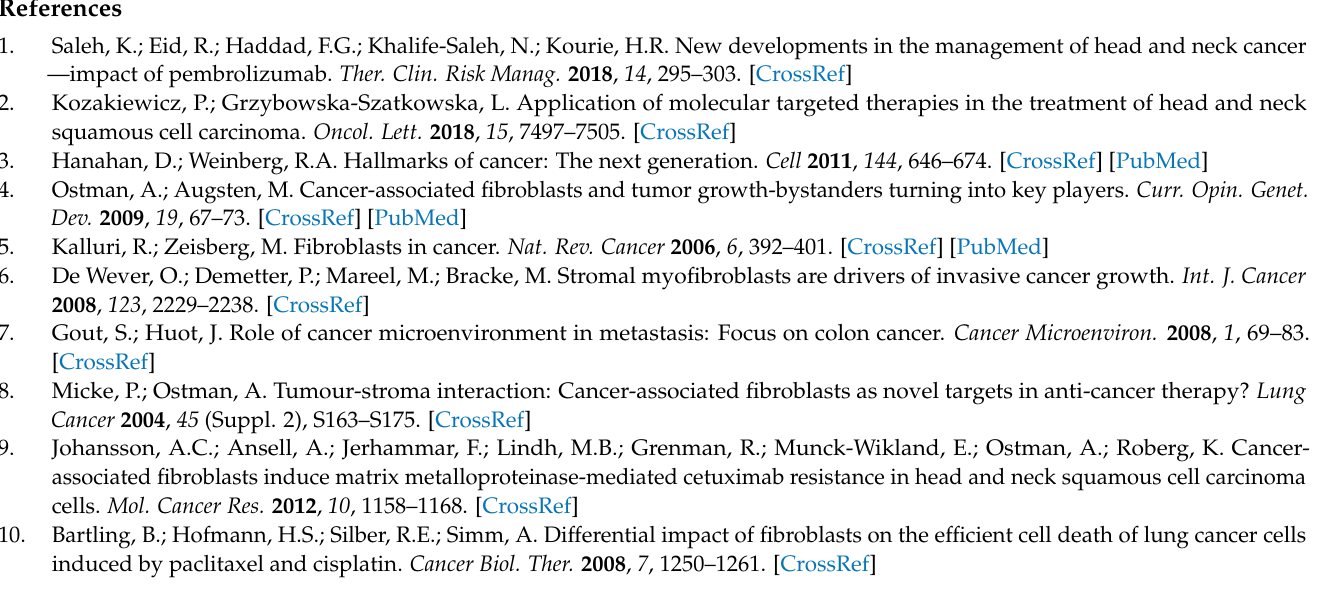
S2: MMP9 expression in HNSCC cells grown in 3D ± . Figure S3: Periostin expression in HNSCC cells grown in 3D ± . Figure S4: Gremlin expression in HNSCC cells grown in 3D ± . Figure S5: Fibromodulin expression in HNSCC cells grown in 3D ± . Figure S6: PCA plot and heat map analysis of 2D_CAF microarray study. Figure S7: PCA plot and heat map analysis of 3D_ CAF microarray study. Table S1: Characteristics of the eight HNSCC cell lines. Table S2: Clinical characteristics of patients. Table S3: Gene expression data from 2DCAF vs. 2DNCAF model. Table S4: Gene expression data 3DCAF vs. 3DN CAF